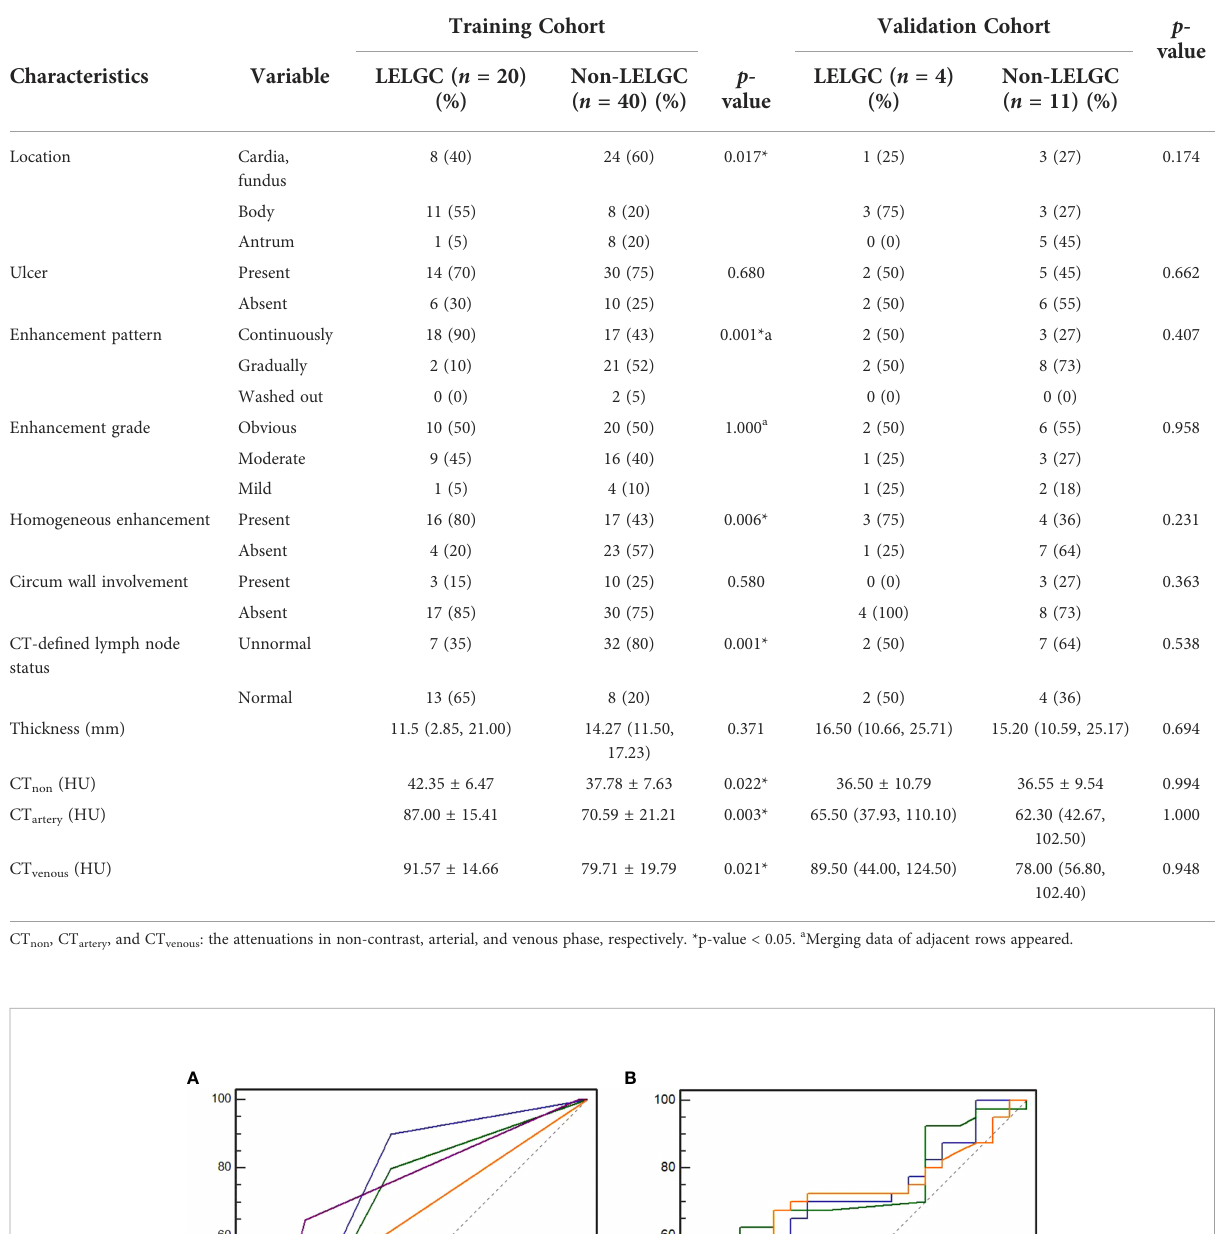
TABLE 2 Univariate analysis of CT characteristics in patients.